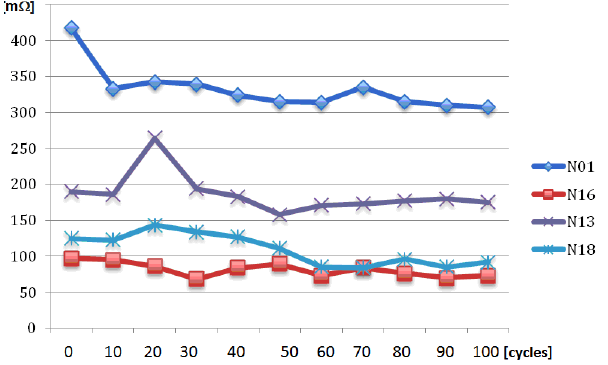
Fig. 6. Plot of the electrical resistance measurement